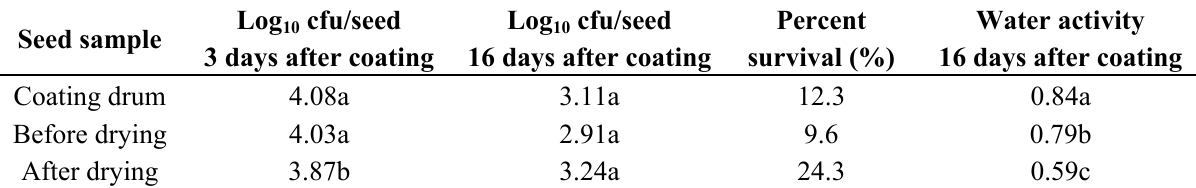
Table 2. Survival of rhizobia and water activity of coated seed before storage at different relative humidities. Data are averages of three replicates. Means followed by different letters are significantly different ( P <